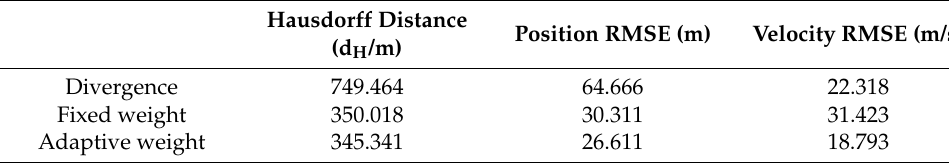
Figure 10. The performance comparisons of the three algorithms in DS2. ( a ) Trajectory. ( b ) Hausdorff distance. ( c ) RMSE of position. ( d ) RMSE of velocity. Table 8. Performance comparisons of the three algorithms in DS2.